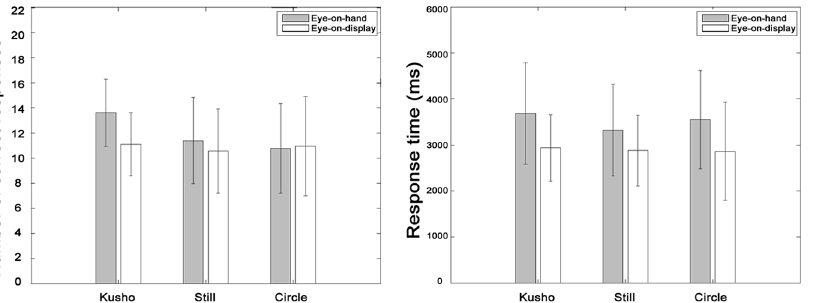
Fig 3. Correct response and response time in Experiment 2. The error bar indicates standard deviation. The number of correct responses in the Kusho condition was significantly larger than in the other two conditions in the Eye-on-hand condition. Response time in the Eye-on-hand condition was significantly longer than in the Eye-on-display condition.